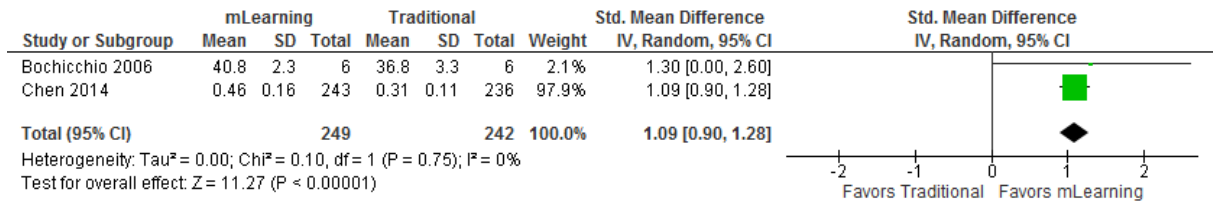
Figure 3. Forest plot for postintervention knowledge outcome (mobile digital education vs traditional education). mLearning: mobile learning; IV: inverse